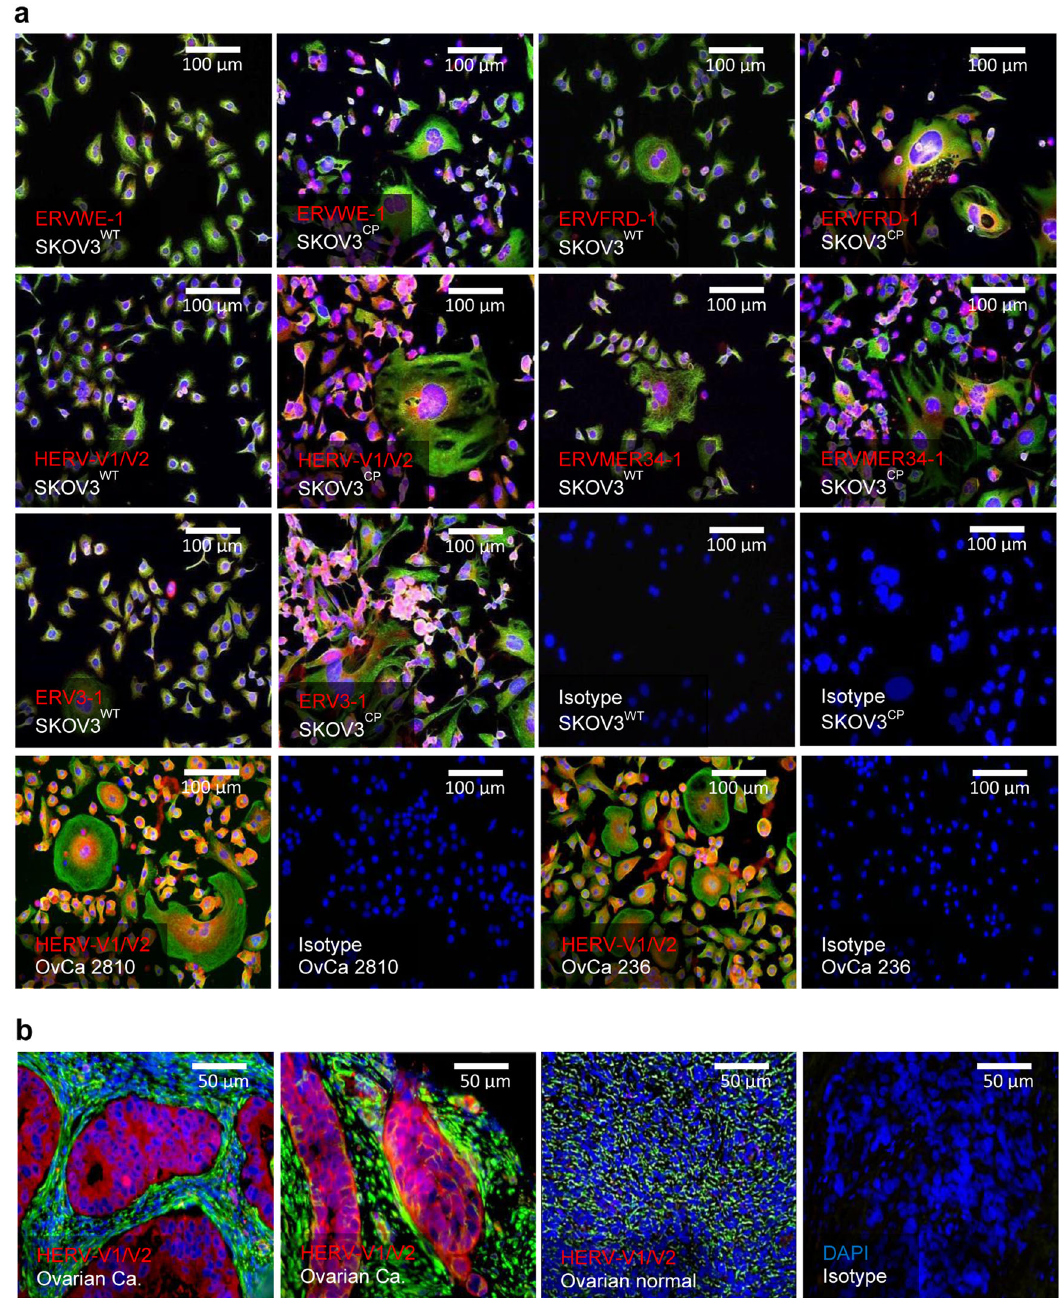
Fig. 1 Expression of HERV proteins in ovarian carcinoma. a ERVWE1 (syncytin 1), ERVFRD-1 (syncytin 2), HERV-V1/V2, ERVMER34-1 and ERV3-1 are expressed in the SKOV3 WT ovarian carcinoma cell line. Of note, in the carboplatin-refractory SKOV3 CP subline, these envelope proteins are remarkably overexpressed, establishing a correlation between HERV expression and high chemotherapy resistance. Isolated ascites cells deriving from heavily carboplatin-treated ovarian carcinoma are highly positive for HERV-V1/V2 envelope proteins. b In tissue paraf fi n sections from ovarian carcinoma of epithelial origin, HERV-V1/V2 expression is mainly con fi ned to the tumour area. It is low in the tumour stromal tissues and almost absent in regular ovarian tissues (IHC analysis, magni fi cation ×20). Results are representative of n = 10 analysed